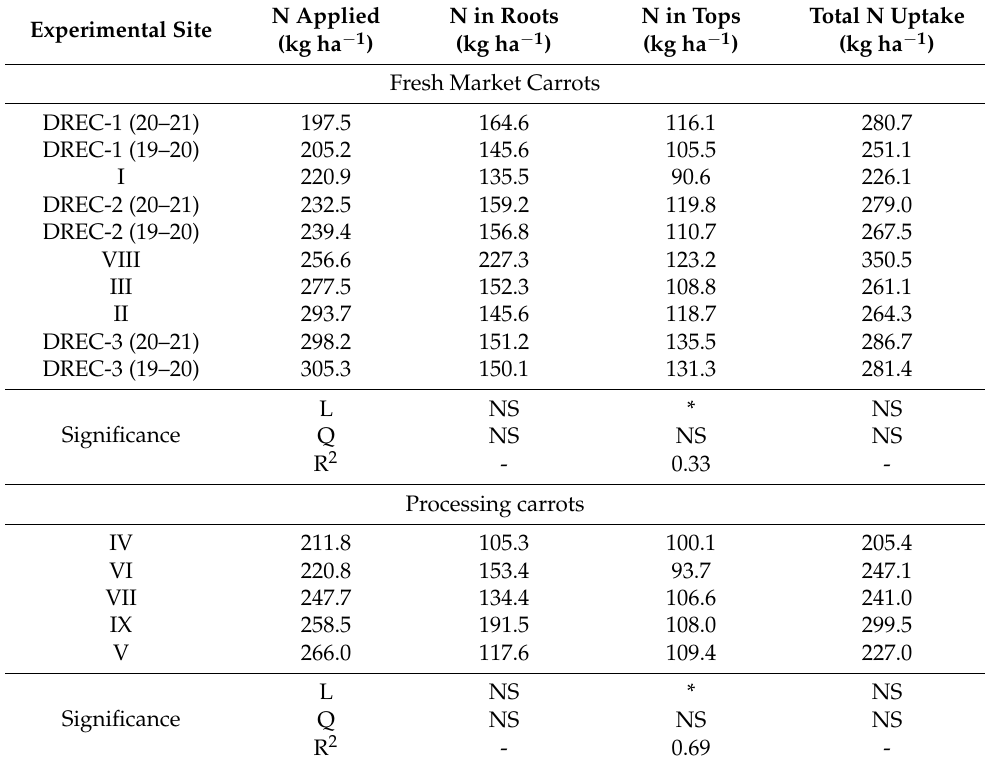
Table 6. Effect of N application rate on N concentration in roots, tops, and plant (total) in fresh market and processing